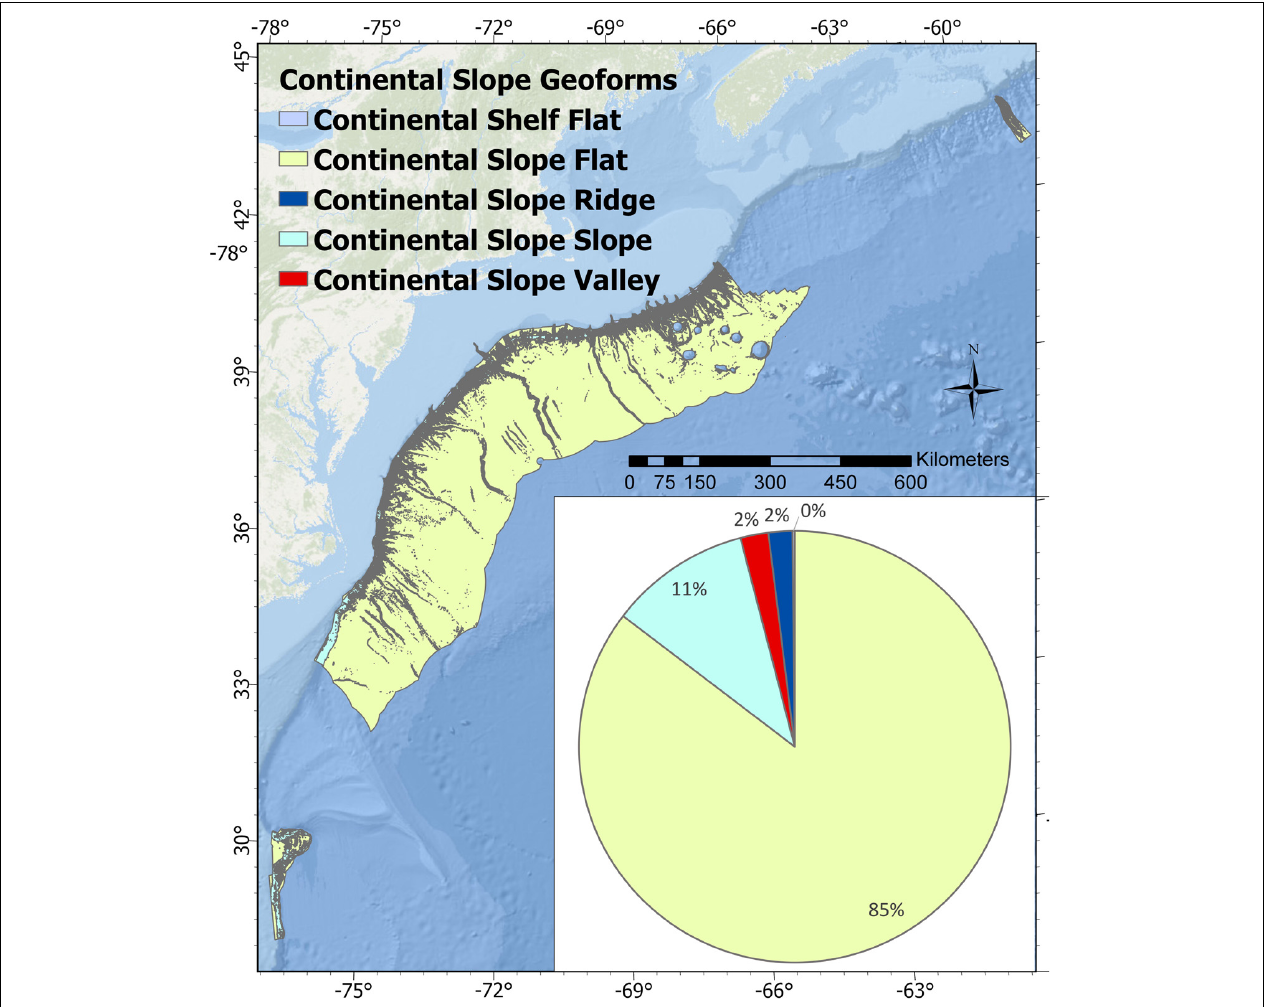
FIGURE 7 | CMECS geoform classifications specific to the continental slope region of the study area. 85% of the area is classified as flats, followed by 11% slopes. Ridges and valleys both comprised 2% each. A very small portion of the mapped area in the study (0.2%) was classified as continental shelf flat (in the shallow areas above the heads of the canyons). These results highlight the fact the continental slope drops off dramatically within a relatively short distance down the steep Atlantic canyons region of the margin, then exhibits a mild gradient down to abyssal depths. While the “continental slope flat” geoform type (yellow green) occurs on the continental slope, it is classified as a flat relative to the steepness of the canyons region, and due to the fact that slopes in these areas are nearly uniformly gradual and tend to range from about 0.1–1.5 degrees.